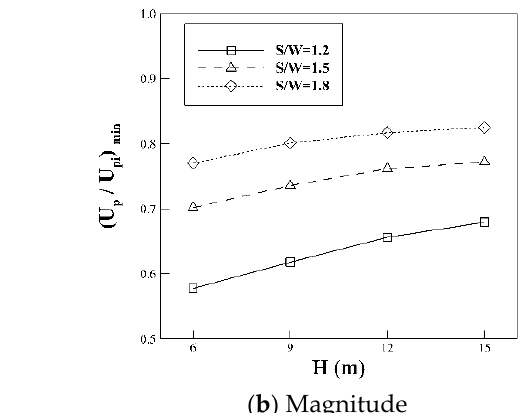
Figure 16. Locations and magnitudes of minimum pedestrian wind speeds.